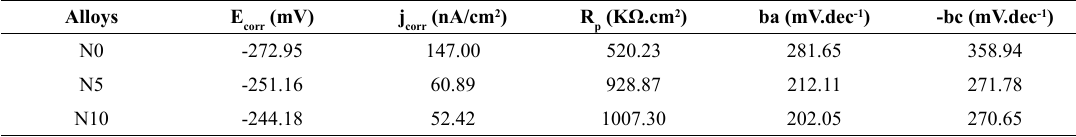
Table 5. Results obtained by the linear potentiodynamic polarization of the N0, N5 and N10 alloys.